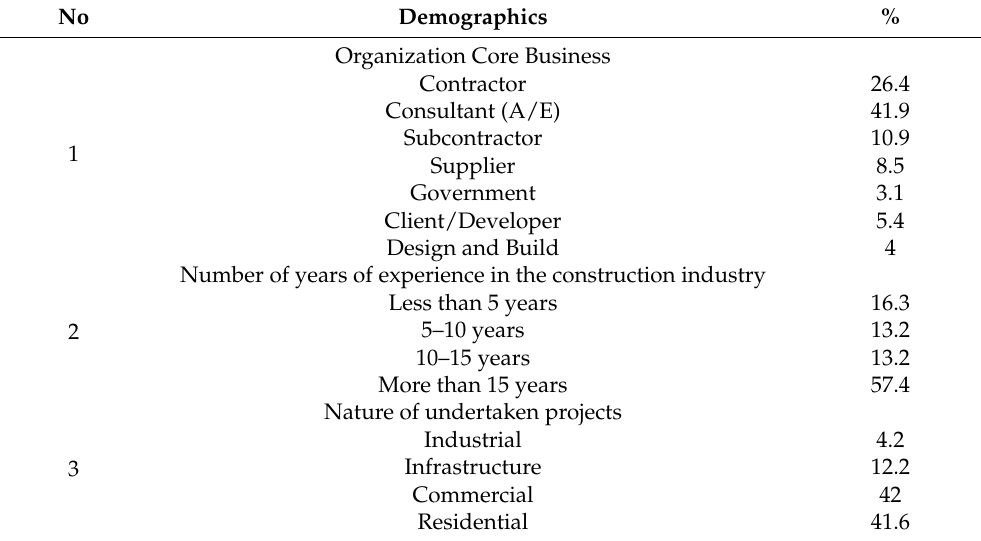
Table 5. Demographic